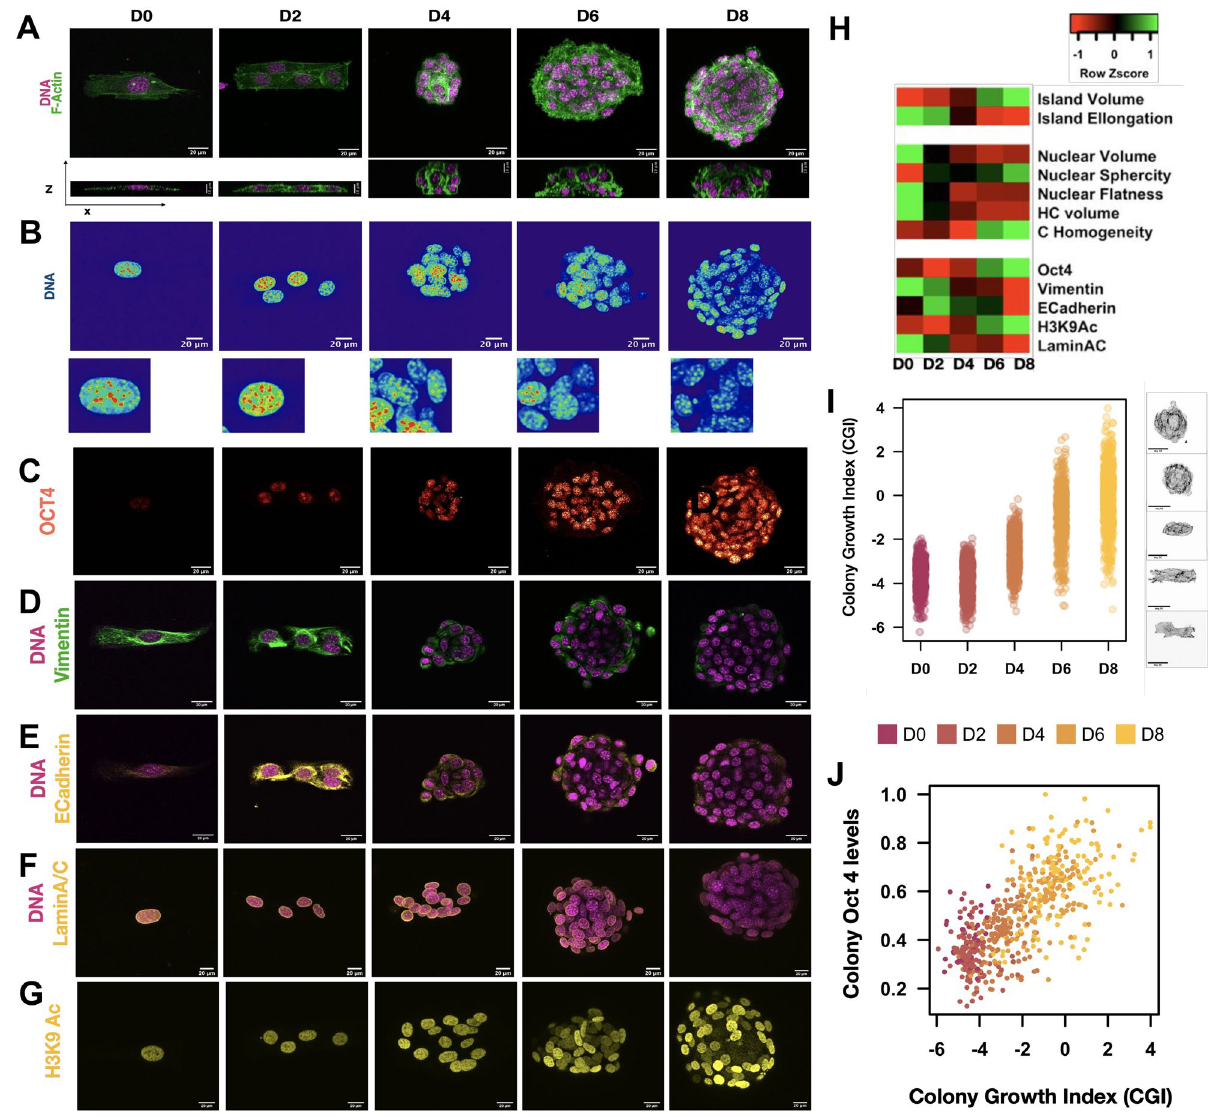
Figure 2. Time course kinetics of reprogramming events demonstrates the coupling between physical and biochemical features: ( A ) representative images colonies stained for DNA (magenta), F-Actin (green) from day 0 to day 8. Bottom row contains an XZ orthogonal slice (Scale bar = 20 μm). ( B ) Representative images of colonies stained for DNA from day 0 to day 8 (Scale bar = 20 μm). Bottom row contains a 17 μm × 17 μm zoomed in section. Representative images of colonies stained for Oct4 (heat colors) ( C ), DNA (Magenta) and Vimentin (green) ( D ), E-Cadherin (yellow) ( E ) Lamin AC ( F ) and H3K9Ac (Yellow) ( G ) from day 0 to day 8. (Scale bar = 20 μm). ( H ) Heatmap showing the changes in the population means of reprogramming markers island morphometrics and chromatin features at various time points. n ≥ 3 replicates for each measure. The values are normalized within each biological replicate. ( I ) Jitter plot of colony Growth Index (CGI) from day 0 to day 8. Each dot represents one colony. Right: Collage of z projected colonies stained for F-Actin arranged in increasing order of CGI. n = 3493 colonies from 5 biological replicates. ( J ) Scatter plot of Average Oct4 levels against Island Growth Index per island from Day 0 to Day 8. Each dot represents one island. n = 1541 colonies from 3 biological replicates. The values are normalized within each biological